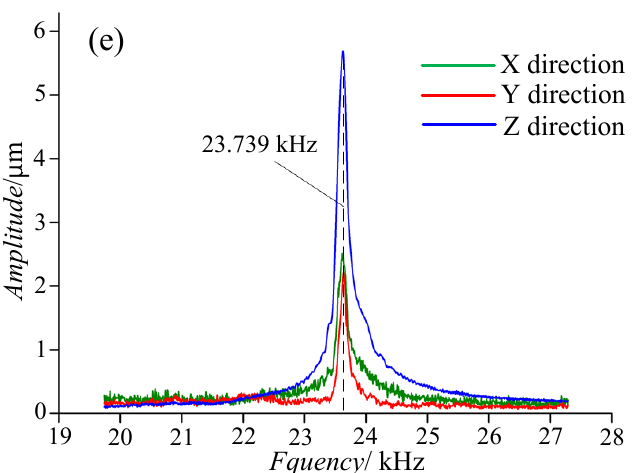
Figure 1. Longitudinal–torsional coupled ultrasonic transducer. ( a ) Transducer of the longitudinal–torsional coupled ultrasonic tool holder. ( b ) Method of the measurement. ( c ) Longitudinal vibration. ( d ) Torsional vibration. ( e ) Amplitude- frequency curve.